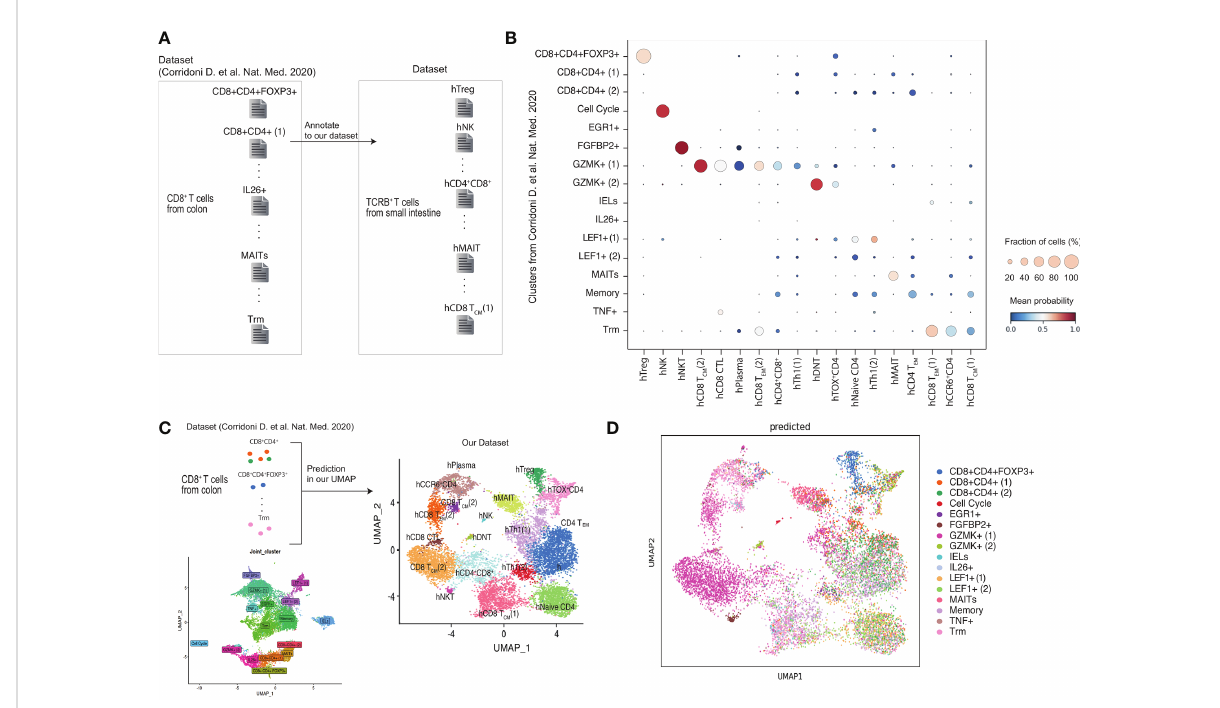
FIGURE 4 Comparison of CD4+CD8A+ T cells between our data and published data set. (A, B) Obtained scRNA-seq data set from previous paper (Corrinoni D. et al) and annotate to our clusters. (C, D) Prediction the cells obtained in the previous report belong to our